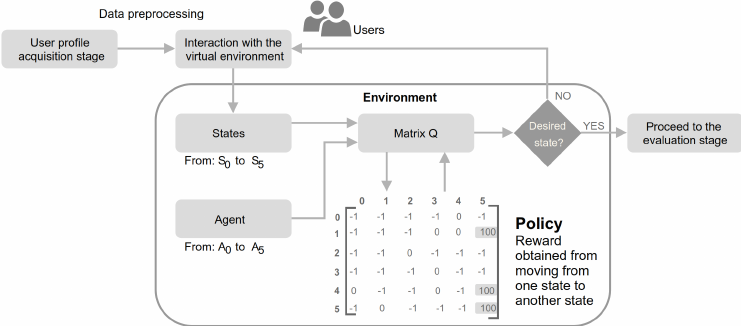
Figure 9. Elements of the interaction stage of the design